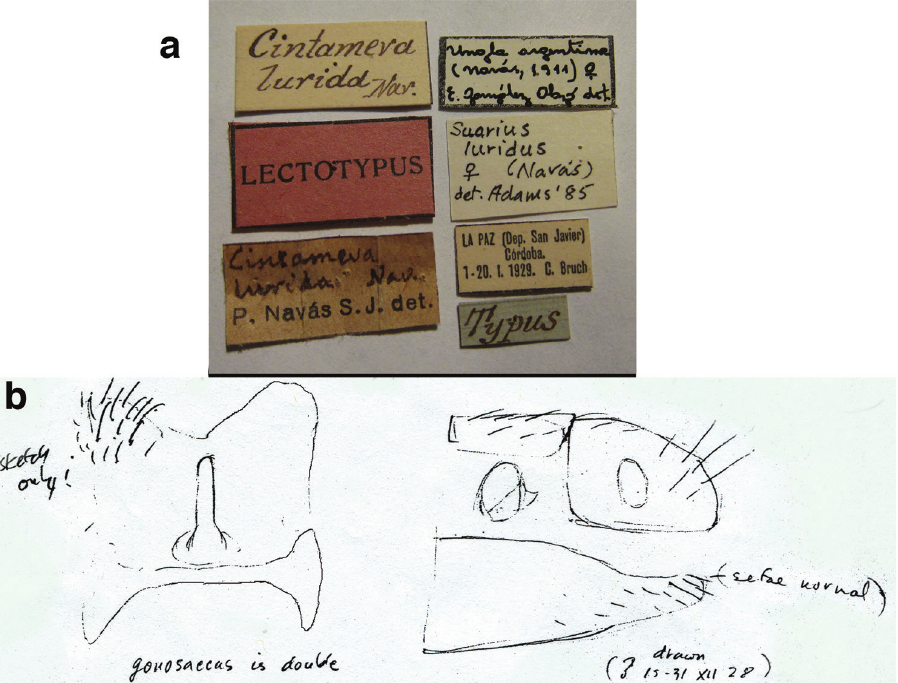
Figure 97. Cintameva lurida Navás: Syntypes, ( a ) labels on female syntype ( b ) sketches of male syntype from P. A. Adams notes, prob. 1985 (all: Argentina; Córdoba,